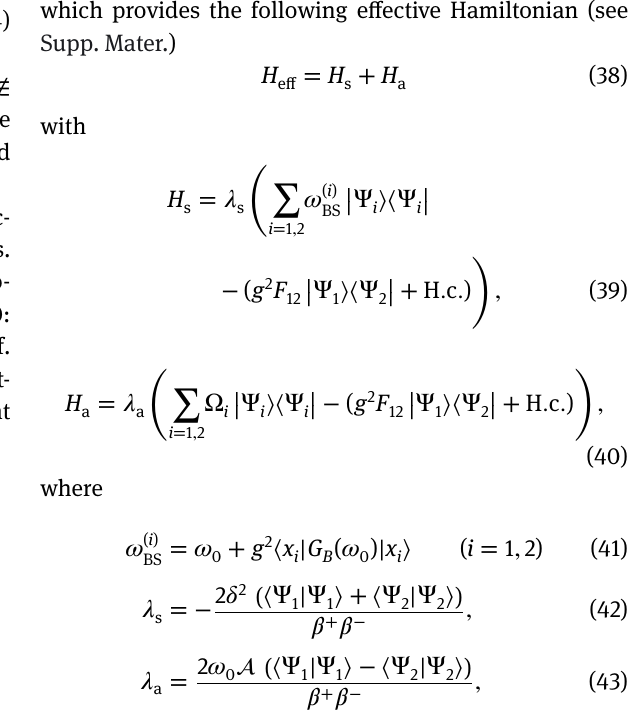
with strength g i